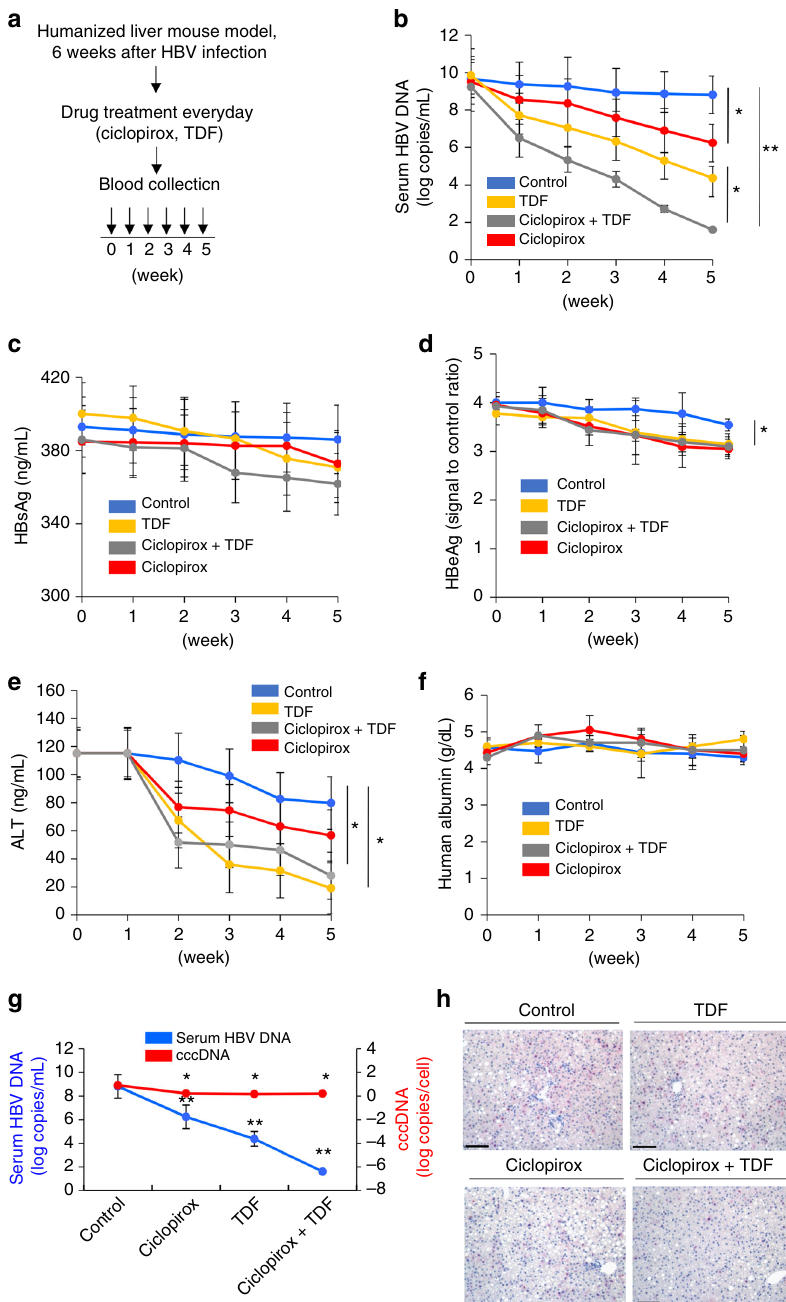
Fig. 7 Antiviral activity of ciclopirox in a humanized liver mouse model of HBV infection. a Schematic depiction of the experiment. PXB mice ( n = 3 per group) were injected via the tail vein with HBV virions (5 × 10 7 copies per mouse, genotype D). After 6 weeks, the mice were treated orally with TDF and/ or ciclopirox (both 5 mg per kg, daily), and serum samples were taken from the orbital sinus every week. b Serum HBV genomic DNA levels measured by quantitative PCR. c Serum HBsAg levels determined by ELISA. d Serum HBeAg levels determined by ELISA. e Serum ALT levels determined by ELISA. f Human albumin levels determined by ELISA. g Intrahepatic cccDNA was determined in nucleic acid extracted from liver specimens obtained after 35 days of treatment. h Immunohistochemical analysis of hepatitis B core antigen (HBcAg) in liver sections obtained after 35 days of treatment (×200 magni fi cation). The data in b – g are representative of three independent experiments, and are expressed as means ± SDs. The error bars represent the ±